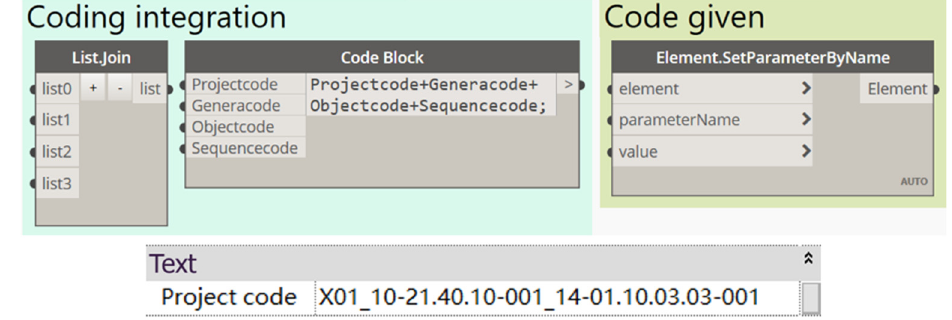
Figure 10. The batch encodes the model.